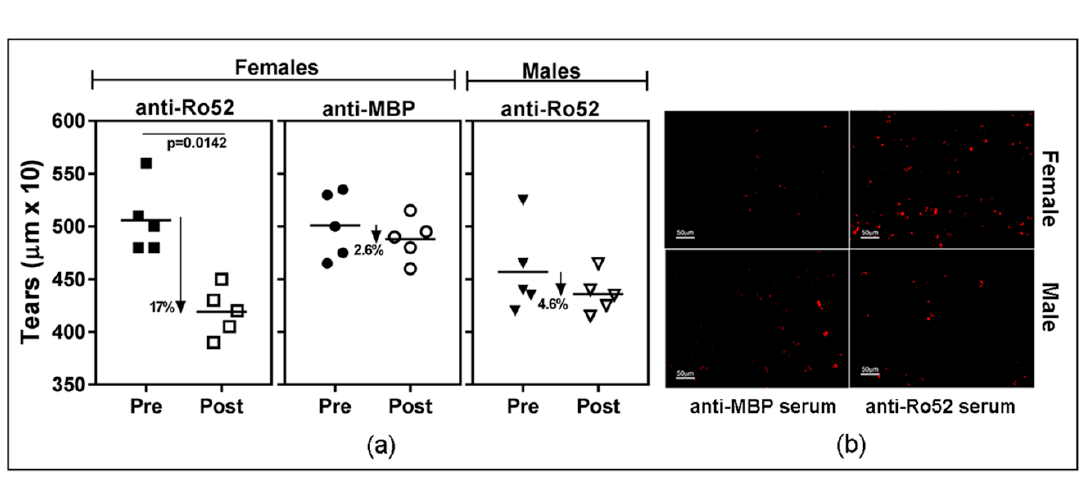
Figure 5. ( a ) Loss of tear production in female NZM2758 mice following passive transfer of anti-Ro52 immune sera. Alum-treated female and male mice were injected either with high titer anti-Ro52 or anti-MBP immune sera and tear production was measured after 24 h. A significant drop in mean tear volume was seen only in female mice. Paired t -test was used to determine statistical significance and a p < 0.05 considered significant; ( b ) Representative images showing rabbit IgG deposition in lacrimal glands of male and female mice following passive transfer of anti-Ro52 or anti-MBP.